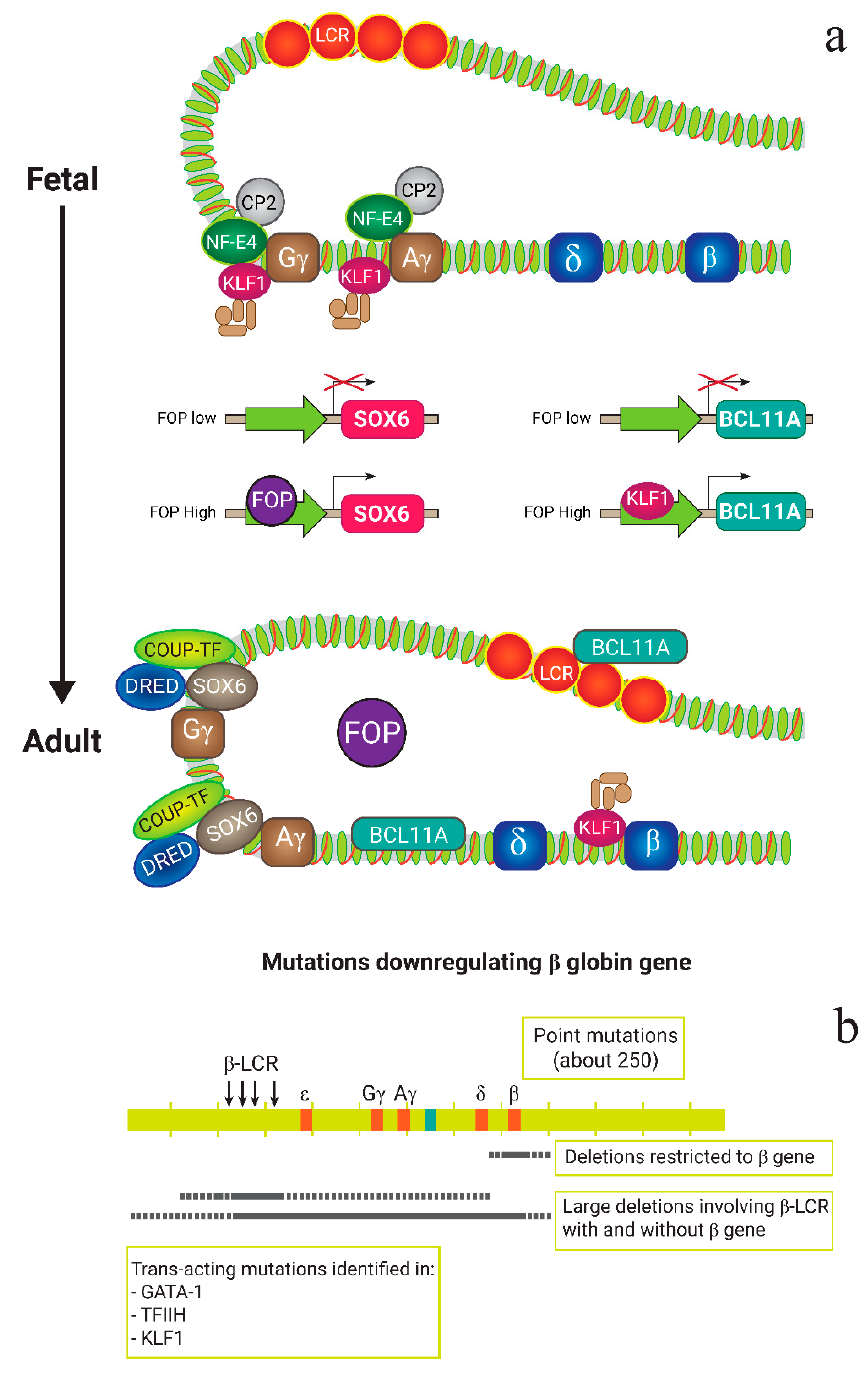
Figure 2. Molecular mechanisms underlying β -thalassemia. ( a ) Role of fetal globin repressors including BCL11A, SOX6 and KLF1 in the expression of γ and β -globin gene: In the fetus, chromatin factor Friend of Prmt1 (FOP) expression is low. Hence, fetal globin repressors including BCL11A, SOX6 and KLF1 did not have any function, and transcription factors such as NF-E4 bind the coding region of the gene and fetal globin (HbF) is synthesized. In adults, expression of FOP is high and fetal globin repressors are activated, bind to the coding site of the gene and β -globin is produced in erythroid progenitors. ( b ) In β -thalassemia, some mutations cause β -globin gene to downregulate, which are known as cis and trans acting elements, leading to downregulation of β gene expression. Mutations in GATA-1, TFIIH, and KLF1 are known as trans acting regulatory elements, while mutations in alleles of β -globin locus are known as cis acting elements.